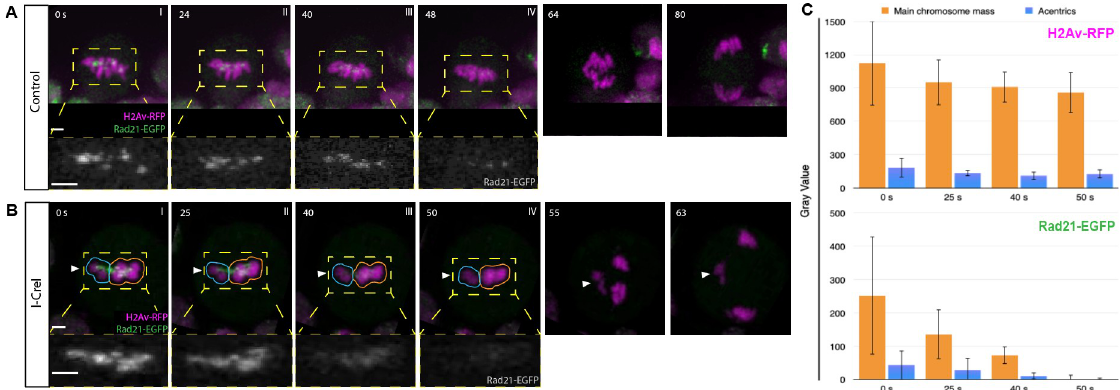
Fig 2. Cohesin complexes are cleared off of acentric sisters upon anaphase onset. Chromosomes labeled with H2Av-RFP (magenta) and cohesin labeled with Rad21-EGFP (green). (A) Stills from a time- lapse movie of a control mitotic neuroblast. (B) Still images from a time- lapse movie of a mitotic neuroblast with I-CreI-induced acentrics (S1 Data). Acentrics (arrowhead) lag on the spindle equator. (C) Bar graphs of a compilation of five videos of I-CreI- expressing neuroblasts showing the relative fluorescence intensities in arbitrary units (AU) of chromosomes (H2Av-RFP, top) cohesin (Rad21-EGFP, bottom) around acentrics (cyan outlined region) and the main mass of chromosomes (yellow outlined region) at time points 50, 40, 25, 0 s, prior to anaphase onset, respectively. Bars, 2 μ m. Time in seconds. Error bars represent standard deviations of fluorescence intensities at all points